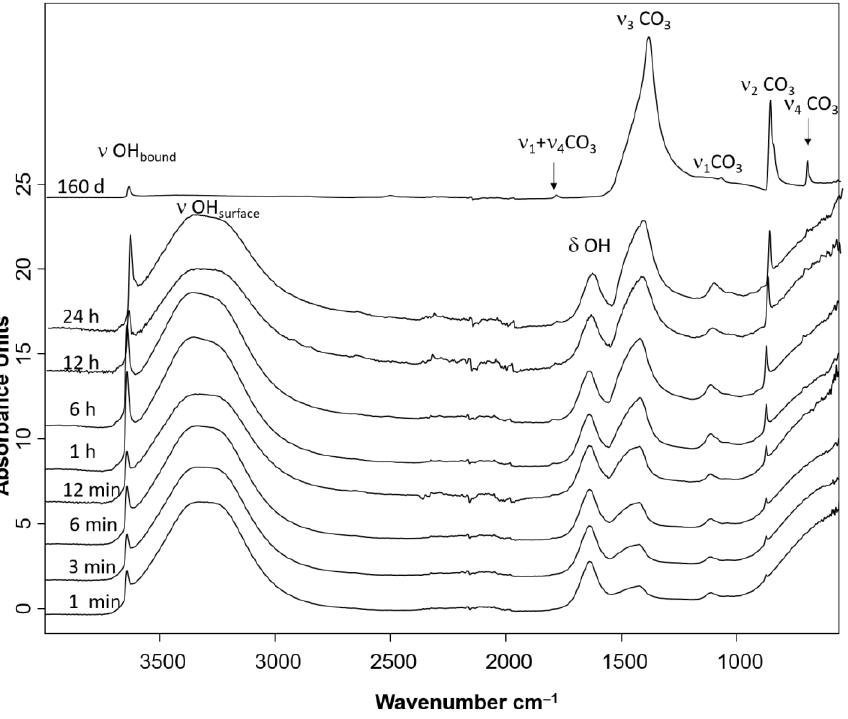
Figure 5. Sequence of IR spectra acquired within the first 24 h and after 160 days.